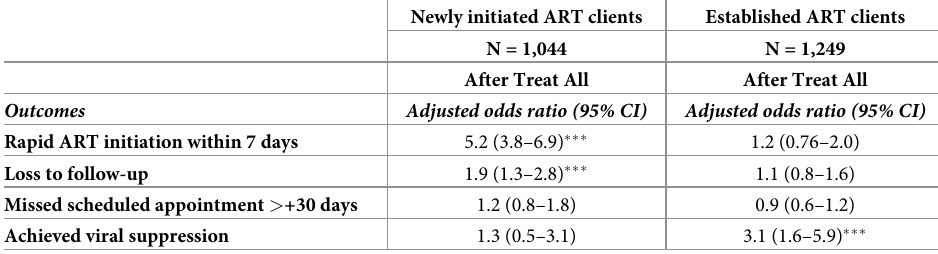
Table 4. Comparisons of key treatment outcomes: Multivariate